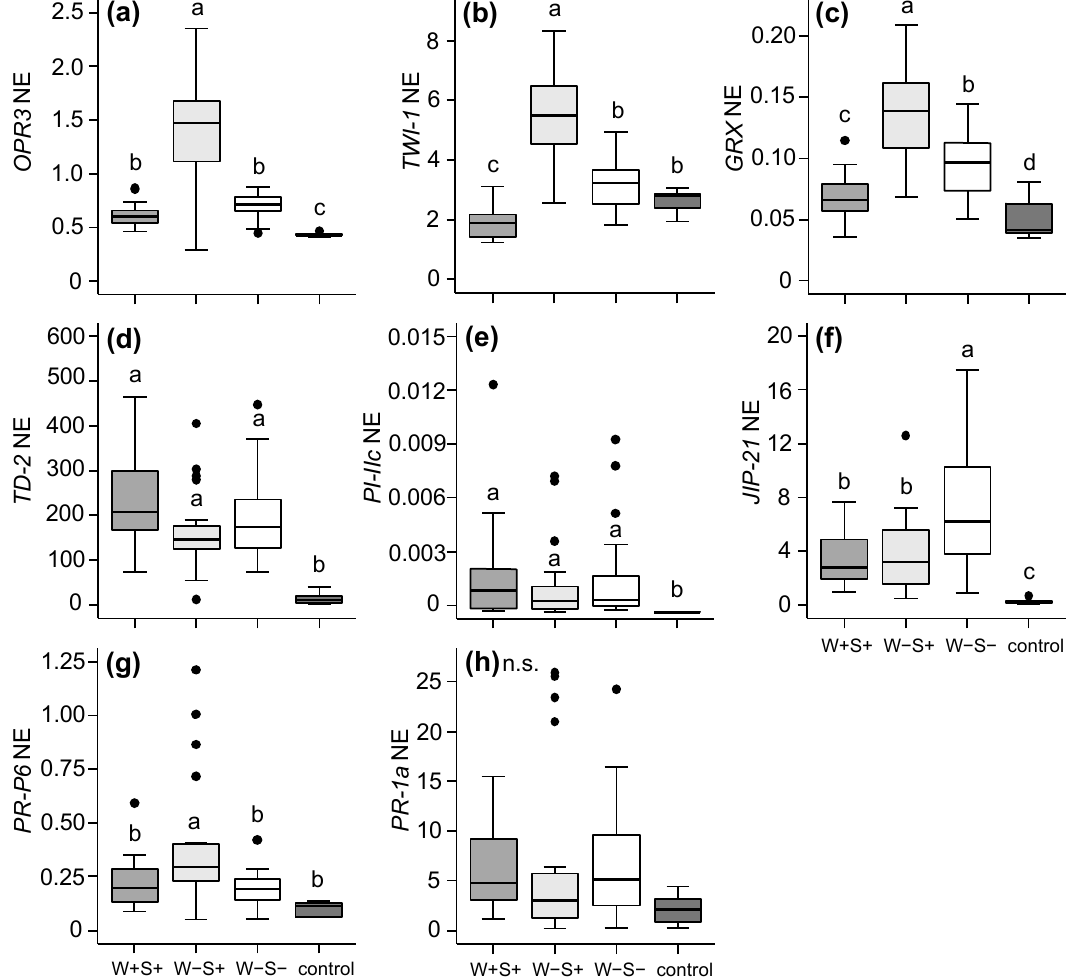
Figure 5. Normalized expression (NE) of plant defence related genes obtained via qRT-PCRs in tomato ( S. lycopersicum ) leaflets after seven days of infestation with the spider mite T. urticae DeLier-1 strain which did (+) or did not ( − ) contain the bacteria Wolbachia (W) and Spiroplasma (S). Control plants were not infested. ( a ) OPDA reductase 3 ( OPR3 ); ( b ) Tomato wound-induced 1 ( TWI-1 ); ( c ) Glutaredoxin ( GRX ); ( d ) Threonine deaminase-2 ( TD-2 ); ( e ) Proteinase inhibitor IIc ( PI-IIc ); ( f ) Jasmonate-inducible protein-21 ( JIP-21 ); ( g ) Pathogenesis-related protein 6 ( PR-P6 ); and ( h ) Pathogenesis-related protein 1a ( PR-1a ); Gene expression levels were normalized to the levels of tomato actin . Boxes span the 25–75 percentiles, horizontal lines in the boxes represent medians, whiskers span 1.5× IQR, dots represent data points outside of this range. Different letters above the boxes indicate significant differences at a level of p ≤ 0.05, after applying linear mixed models followed by Tukey multiple comparisons with Holm adjustment. n.s.: not significant.